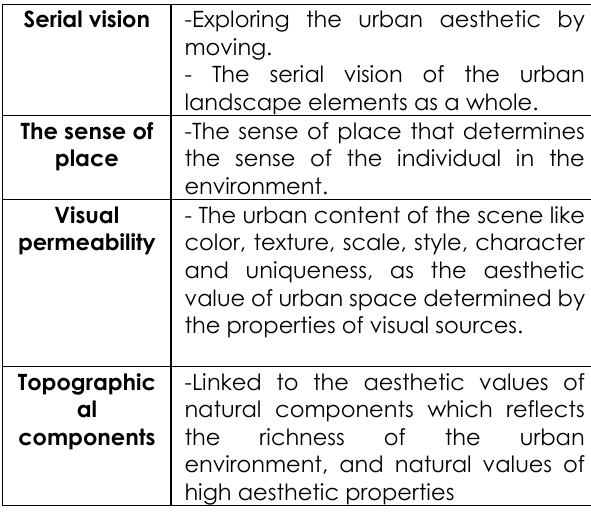
Table 2. Basic principles of aesthetic space organization.